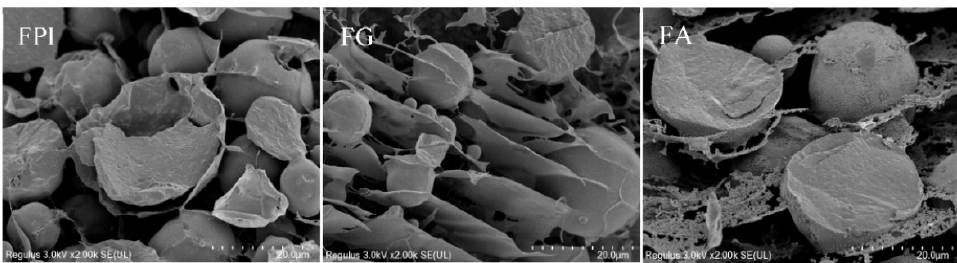
Figure 6. The cryo-SEM imaging of emulsions constructed by FPI, FG, and FA. FPI: flaxseed protein isolate; FG: flaxseed globulin; FA: flaxseed albumin.